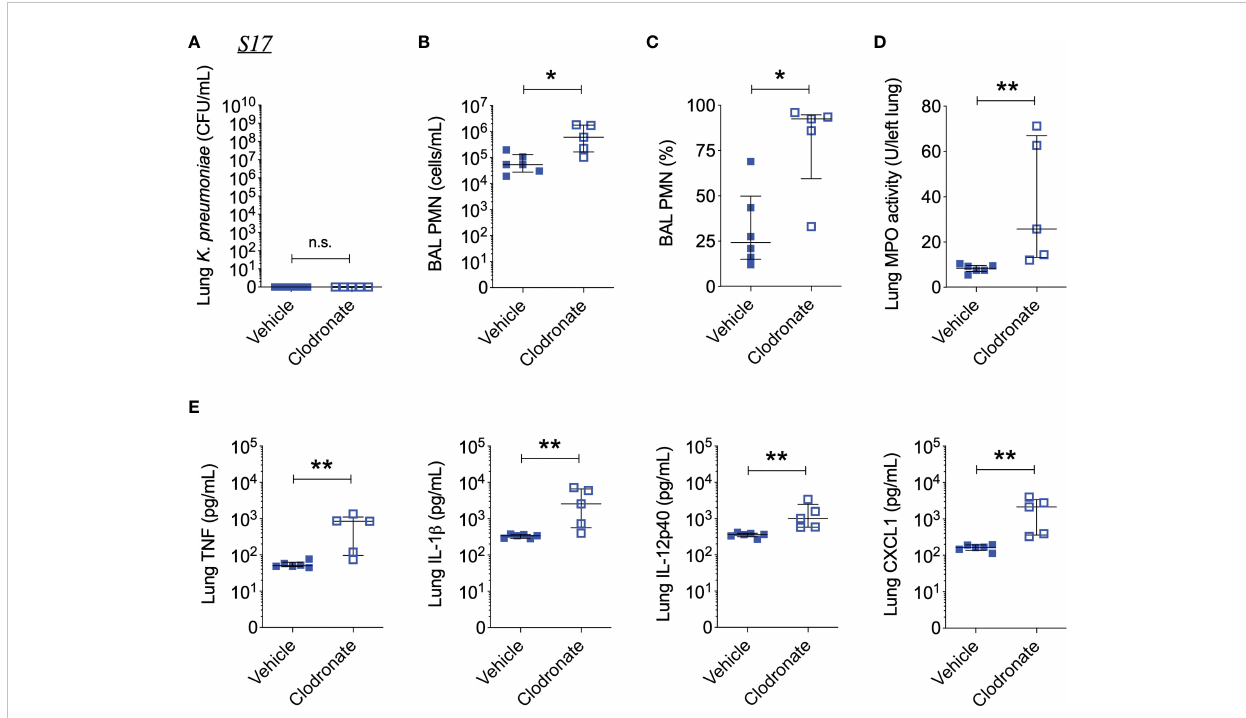
FIGURE 6 Alveolar macrophage depletion with clodronate is associated with exacerbated in fl ammation 48 hours after intrapulmonary infection with the phagocytosis-sensitive S17 isolate. (A) CFU of Kp in lung homogenates obtained from C57BL/6J mice treated with clodronate (N=5, intratracheal, 0.5mg/mouse) or empty liposomes (N=6) and subsequently infected with S17 Phago-Sens (inoculum: 10 3 CFU) for 48 hours. (B) Number and (C) percentage of PMNs in BAL specimens from S17-infected mice treated with clodronate or vehicle. (D) MPO activity in lung tissue homogenates from S17-infected mice treated with clodronate or vehicle. (E) Levels of TNF, IL-1 b , IL-12p40, and CXCL1 in lung tissue homogenates from S17- infected mice as determined by ELISA. Data represent medians ± interquartile range + individual data points. *p<0.05, **p<0.01, n.s.: not signi fi cant (Mann-Whitney